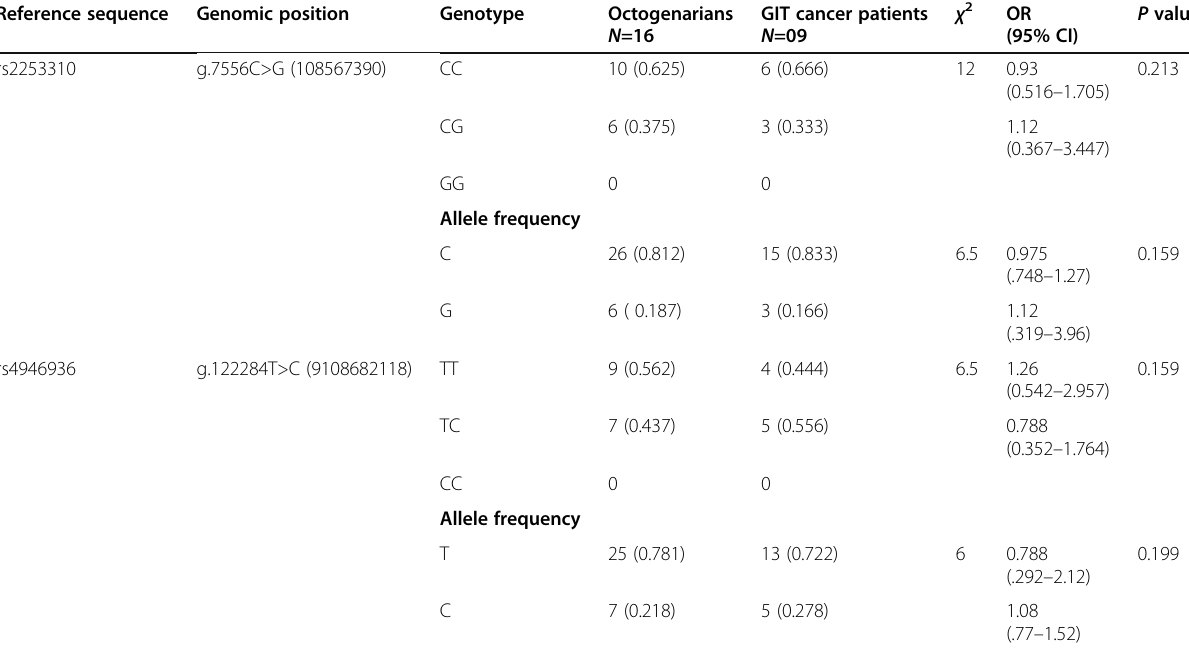
Table 2 Genotype and allelic frequencies of the FOXO3 gene variants compared between octogenarians and gastrointestinal tract cancer patients Reference sequence